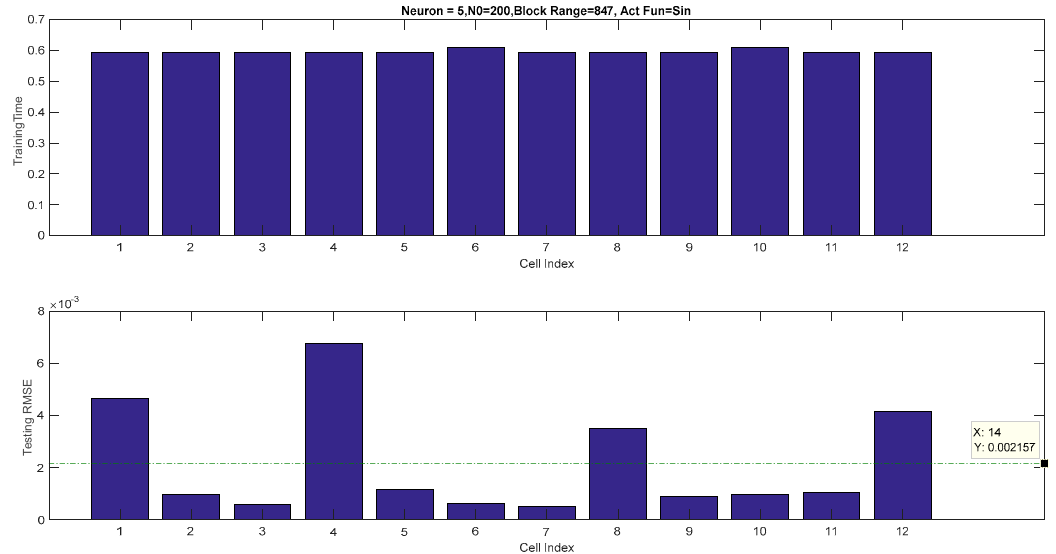
Figure 22. Training time and testing RMSE for a 12-cell battery at 25 °C for five neurons (N0 = 200, block range = 847, sinusoidal activation function).